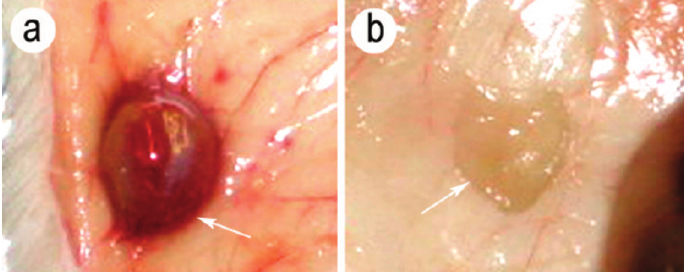
Figure 14. Macroscopic appearance of ( a ) chitosan sponge and ( b ) electrospun nanofibers 12 weeks after subcutaneous implantation. Sponges appear red and thickened by fibrous deposit, whereas nanofiber scaffolds remained white and could hardly be distinguished from the neighboring mouse tissue. Reprinted with permission from [132], Copyright © 2011 American Chemical